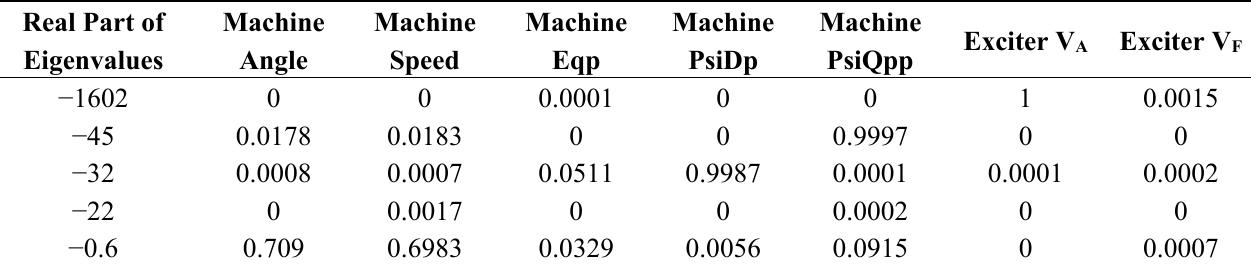
Table 4. Participation factor of a generator at bus